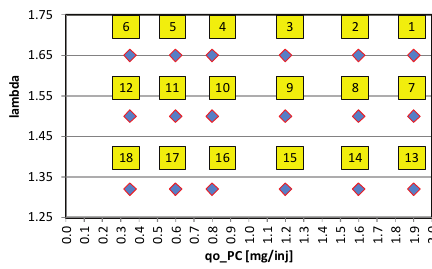
Fig. 12. The research points table after measured value normalization